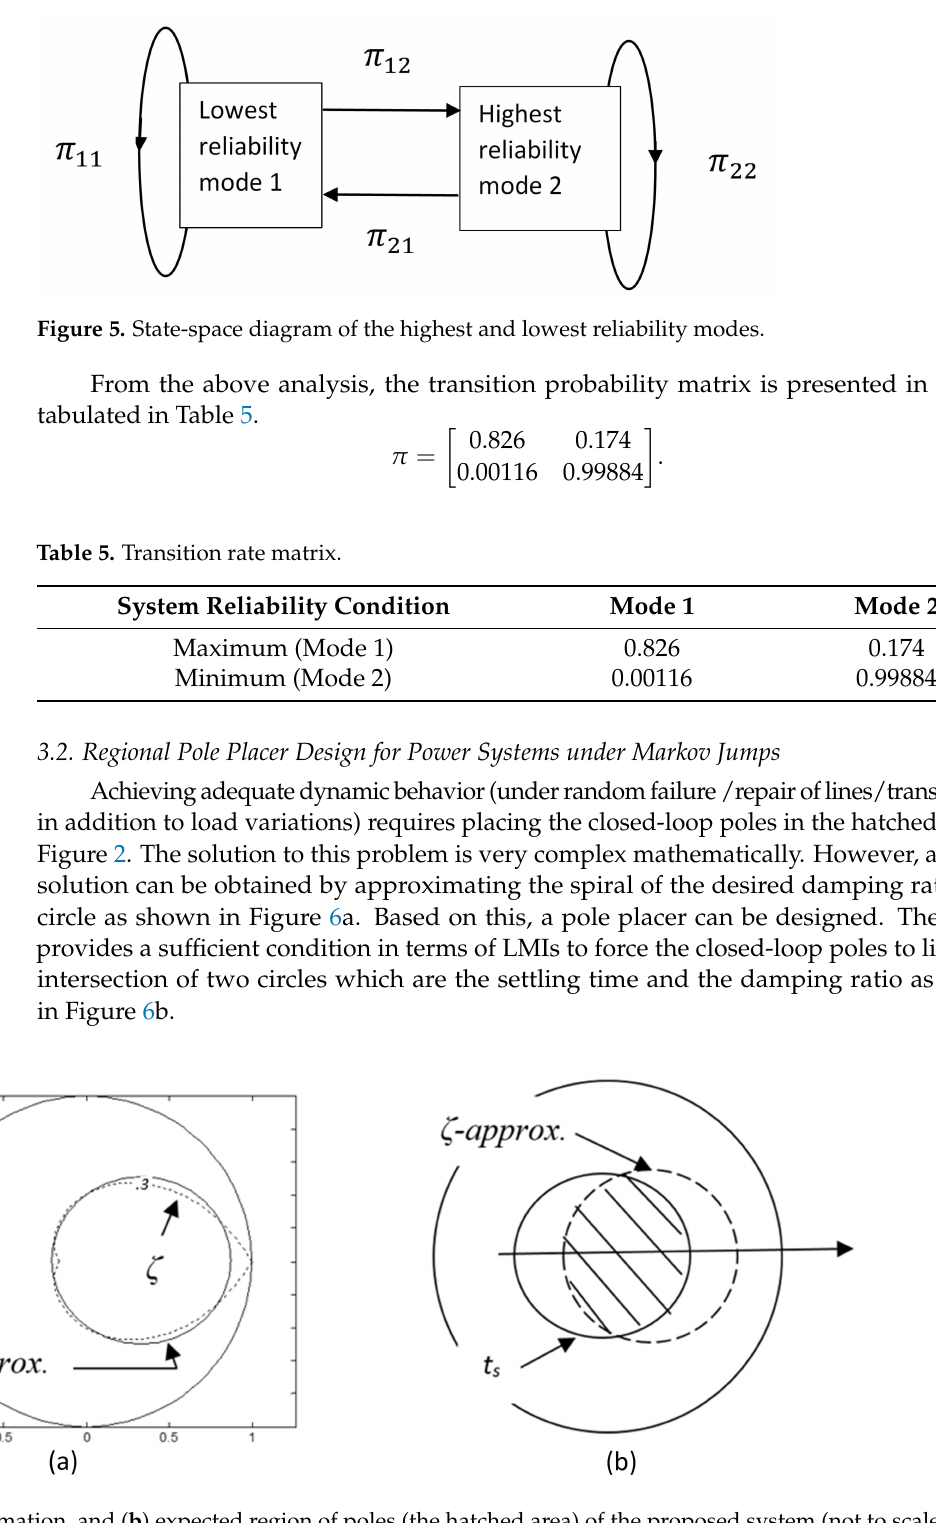
Figure 6. ( a ) ζ -approximation, and ( b ) expected region of poles (the hatched area) of the proposed system (not to